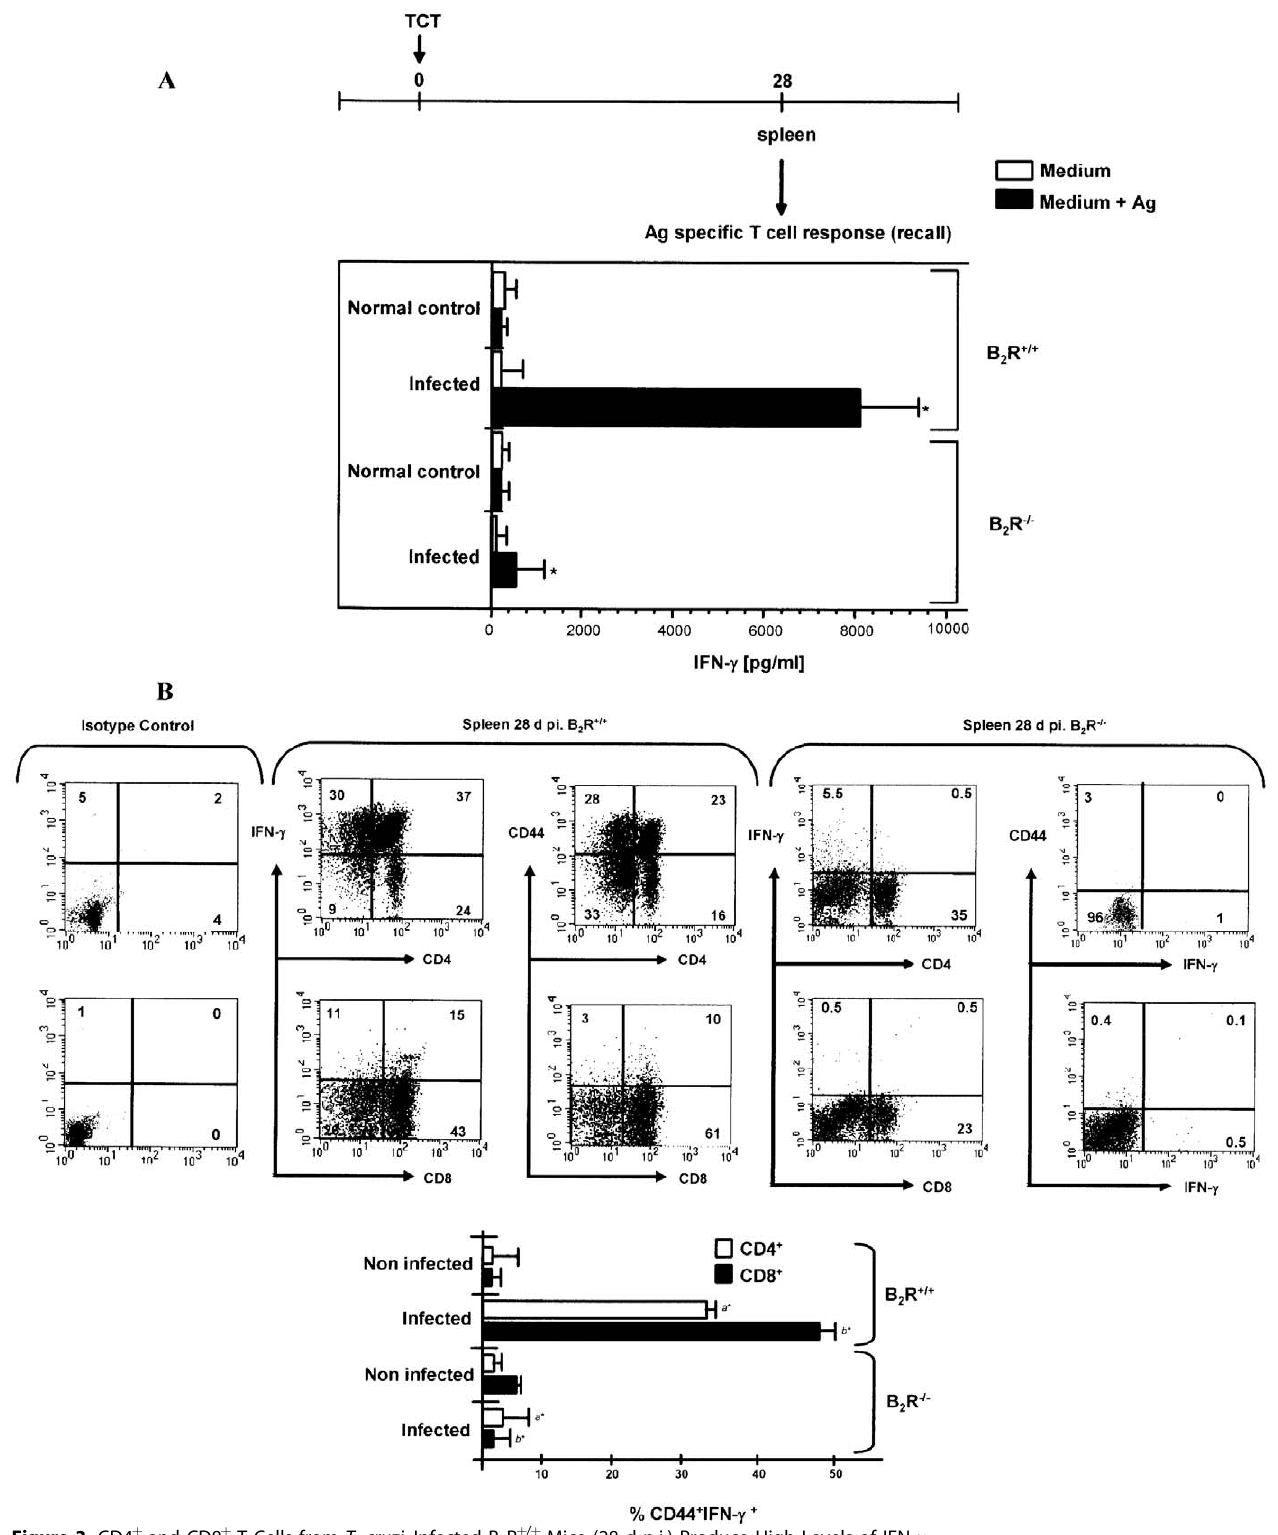
Figure 3. CD4 þ and CD8 þ T Cells from T. cruzi –Infected B 2 R þ / þ Mice (28 d p.i.) Produce High Levels of IFN- c (A) Assessment of IFN- c production by splenocytes isolated from B 2 R þ / þ and B 2 R (cid:2) / (cid:2) mice infected at 28 d with Dm28c TCT. Cells were stimulated with T. cruzi Ag (25 l g/ml) for 72 h at 37 8 C. Culture supernatants were harvested and assayed for IFN- c . (B) T cells were stimulated with T. cruzi Ag (25 l g/ml) for 18 h at 37 8 C and were stained for CD4 or CD8, IFN- c , and CD44 marker as described in Materials and Methods. Cells from B 2 R þ / þ mice were gated on CD4 þ IFN- c þ or CD8 þ IFN- c þ lymphocytes and examined for expression of CD44. Dot plot profiles( n ¼ 5mice/group)arerepresentative ofresultsobservedinthreeindependent experiments.Columngraphs(lowerpanel)indicatethemean 6 SD ofthefrequencyof IFN- c -producingCD4 þ CD44 þ orCD8 þ CD44 þ Tcells( n ¼ 3).Statisticsweredoneby ANOVAandpair-wisecomparisonsweredoneby the Tukey test (*, p , 0.01). doi:10.1371/journal.ppat.0030185.g003 PLoS Pathogens |